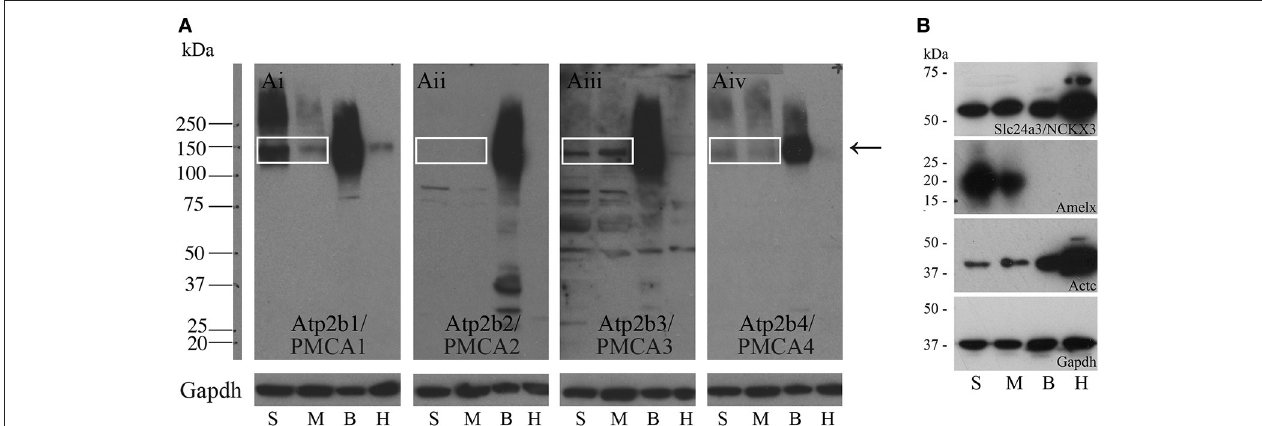
FIGURE 2 | Western blot analyses of PMCA1-4, and NCKX3 in secretory-stage and maturation-stage rat enamel organs. (A) Western blot analysis for PMCA1 (Ai) , PMCA2 (Aii) , PMCA3 (Aiii) and PMCA4 (Aiv) . Samples are secretory-stage enamel organ cells (S), maturation-stage enamel organ cells (M), brain tissue (B) and heart tissue (H). Brain and heart samples are shown for comparison, as all PMCAs are highly expressed in brain and at lower levels in the heart (Brini and Carafoli, 2011; Brini et al., 2017). Molecular weight markers are indicated at left. The expected molecular weights for PMCA1, PMCA2, PMCA3, and PMCA4 are ∼ 130, 133, 123, and 129 kDa, respectively. The bands are seen for PMCA1, PMCA3, and PMCA4 (boxed and arrow). No expression of PMCA2 is evident. GAPDH is used here as a loading control. (B) Western blot analysis of NCKX3. The expected molecular weight for NCKX3 is ∼ 60 kDa. NCKX3 is expressed in all 4 tissue samples tested, with similar expression noted in both secretory-stage and maturation-stage enamel organ cells, and brain tissue. Relatively higher levels of NCKX3 expression can be appreciated in heart tissue. Amelx and Actc are used as controls as expression is highest in secretory-stage ameloblasts (Lacruz et al., 2012a,b) and heart tissue (Hamada et al., 1982) respectively. GAPDH is used here as a loading control.